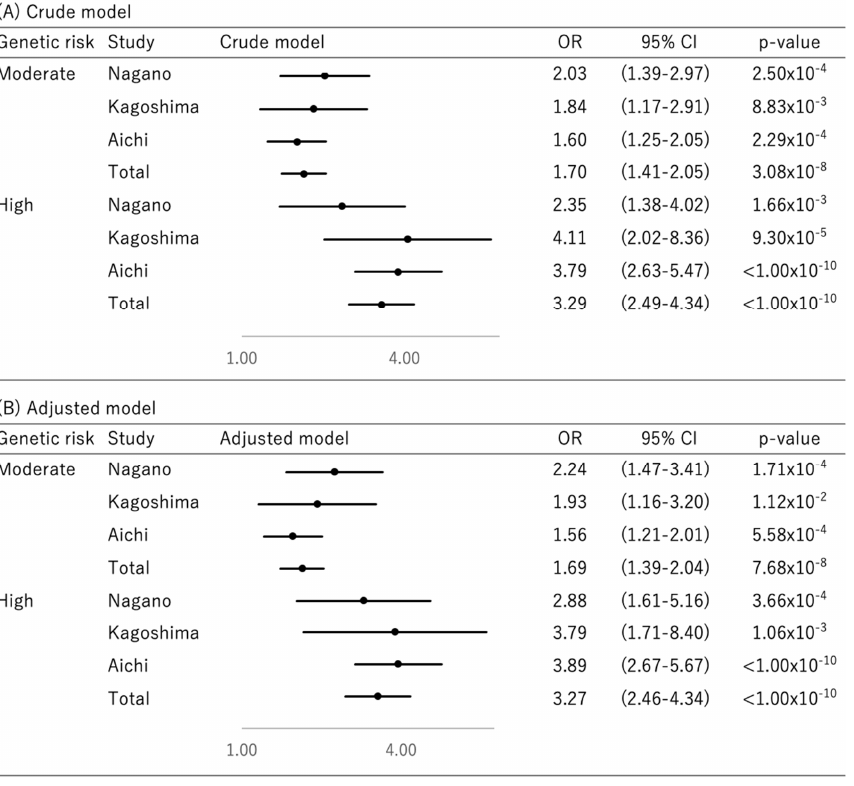
Figure 1. Odds ratio of breast cancer risk in each risk group; OR; odds ratio, CI; confidence interval. ( A ) Age was included in the crude model. ( B ) Age, BMI, ethanol intake, smoking, physical activity, family history of breast cancer, age at menarche, parity, number of births, age at first birth, breastfeeding and hormone therapy were included in the adjusted model. Genetic risk group was defined by the number of risk alleles, with 0–10, 11–16 and 17–28 risk alleles defined as the low-, moderate- and high-risk groups, respectively.